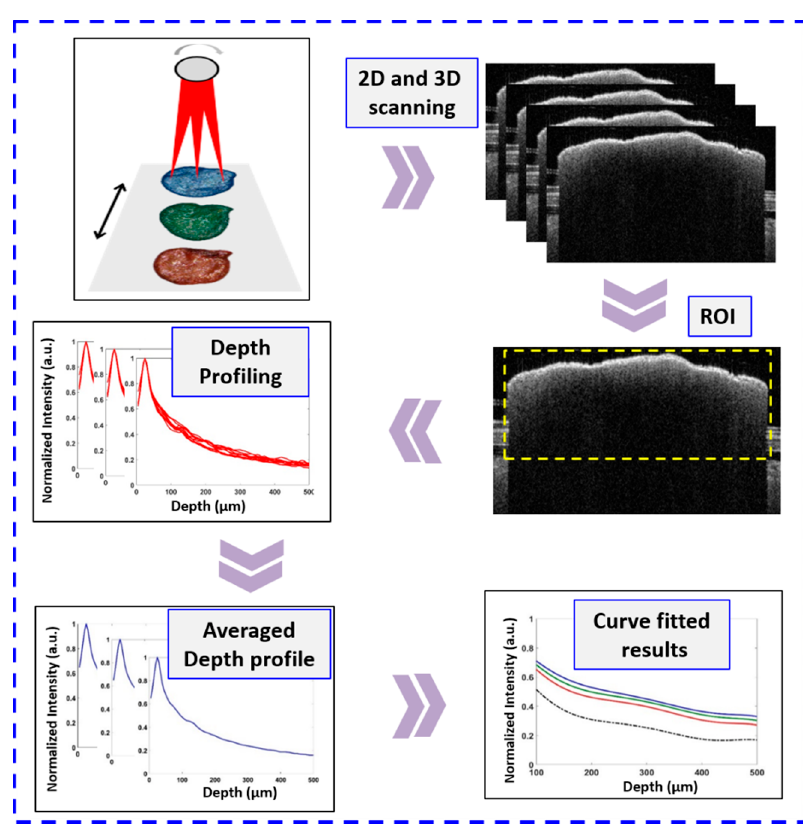
Figure 2. A flowchart explaining the experimental algorithm used to obtain the depth intensity profile in different seed samples. in different seed